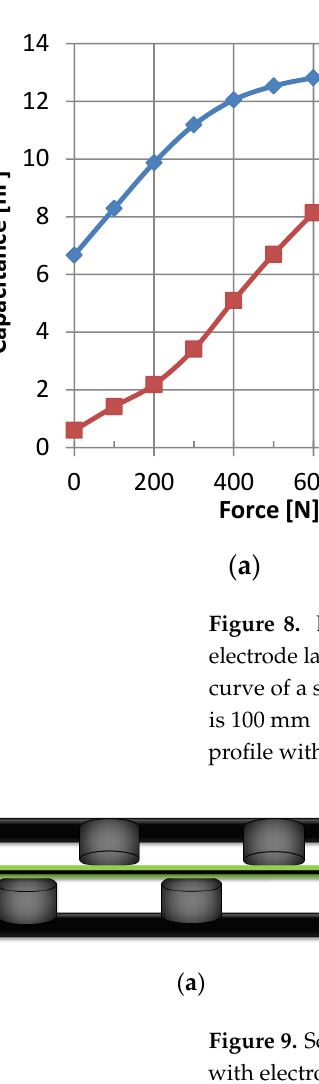
( b ) Figure 10. Photographs of elastomer sheets with knot profiles without and with electrode layer ( a ) and comparison of the dependence of the measured capacitance of pressure sensors with wave pro- files, bar profiles and knot profiles on the applied force, where all profiles with an area of 100 mm × 100 mm are covered by electrode layers ( b ) [100].